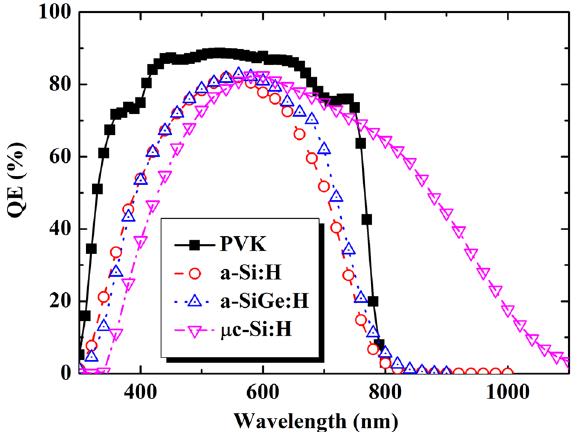
Figure 1. Measured QE spectra of the various top sub-cell candidates. The black, red, blue, and magenta lines depict the QE of the PVK, a-Si:H, a-SiGe:H, and μc-Si:H thin film solar cell, respectively.